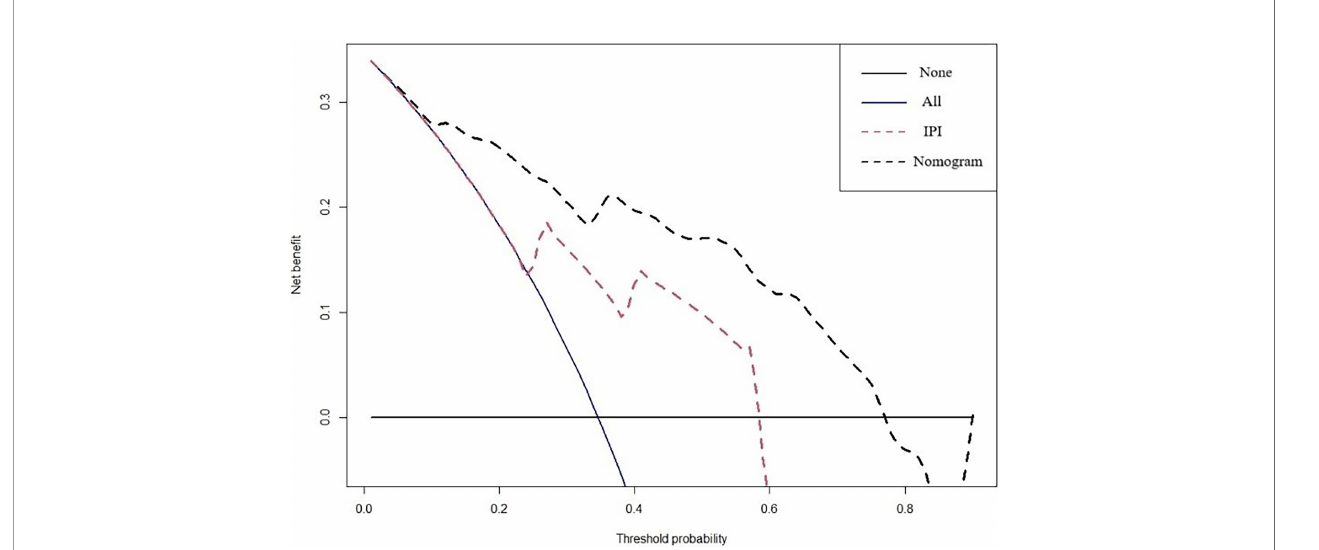
FIGURE 6 | DCA curves to evaluate the clinical utility of different decision strategies. The red line represents the IPI system, and the black line represents the nomogram for CD5+